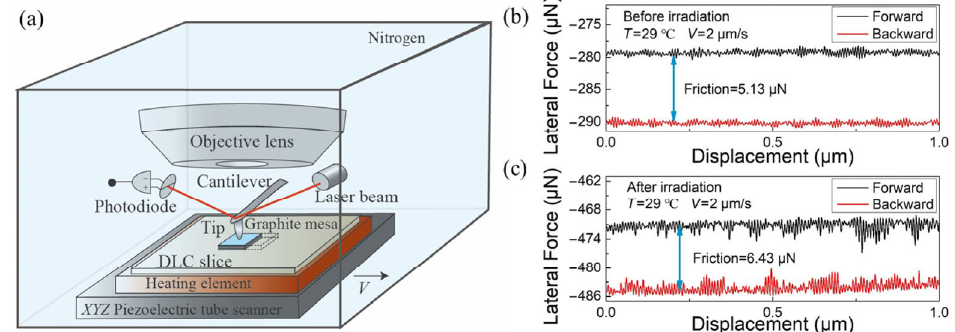
Fig. 1 (a) Schematic experimental setup. The graphite/DLC heterojunction was mounted on the AFM with a heating stage and an environment chamber filled with N 2 . The friction was measured by sliding the graphite mesa against the DLC surface using the AFM tip; typical lateral force versus displacement curves for mesas before (b) and after (c) Argon plasma irradiation. The average friction force is calculated as